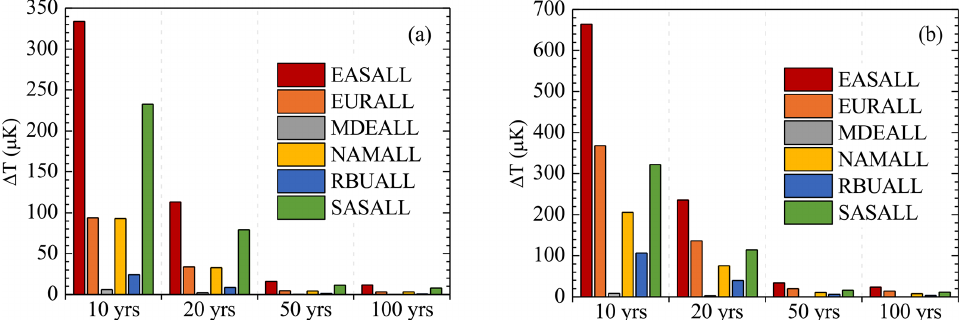
Figure 8. Arctic surface temperature response to 20% regional BC emission reductions in (a) summer and (b) winter after 10, 20, 50, and 100 years.